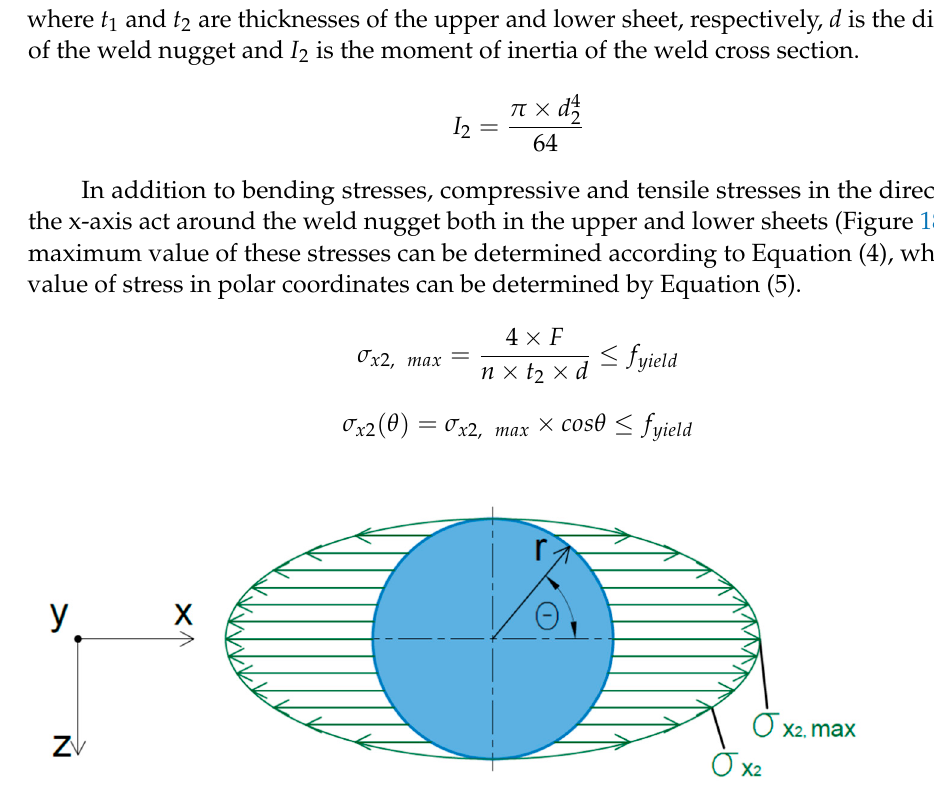
Figure 18. Stress distribution around the weld nugget.